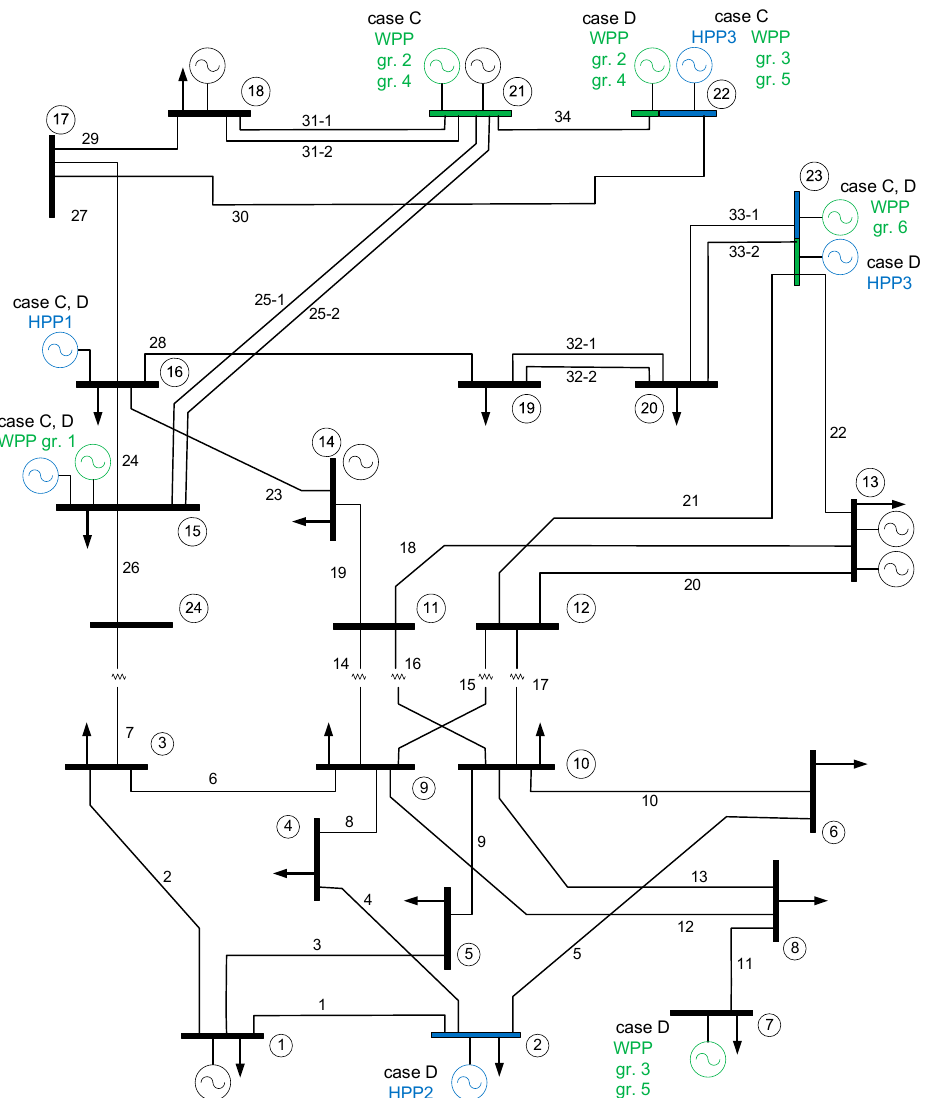
Figure 3. The RTS 96 test network with the locations of the wind power plants (WPPs) and regulating hydro power plants (HPPs).